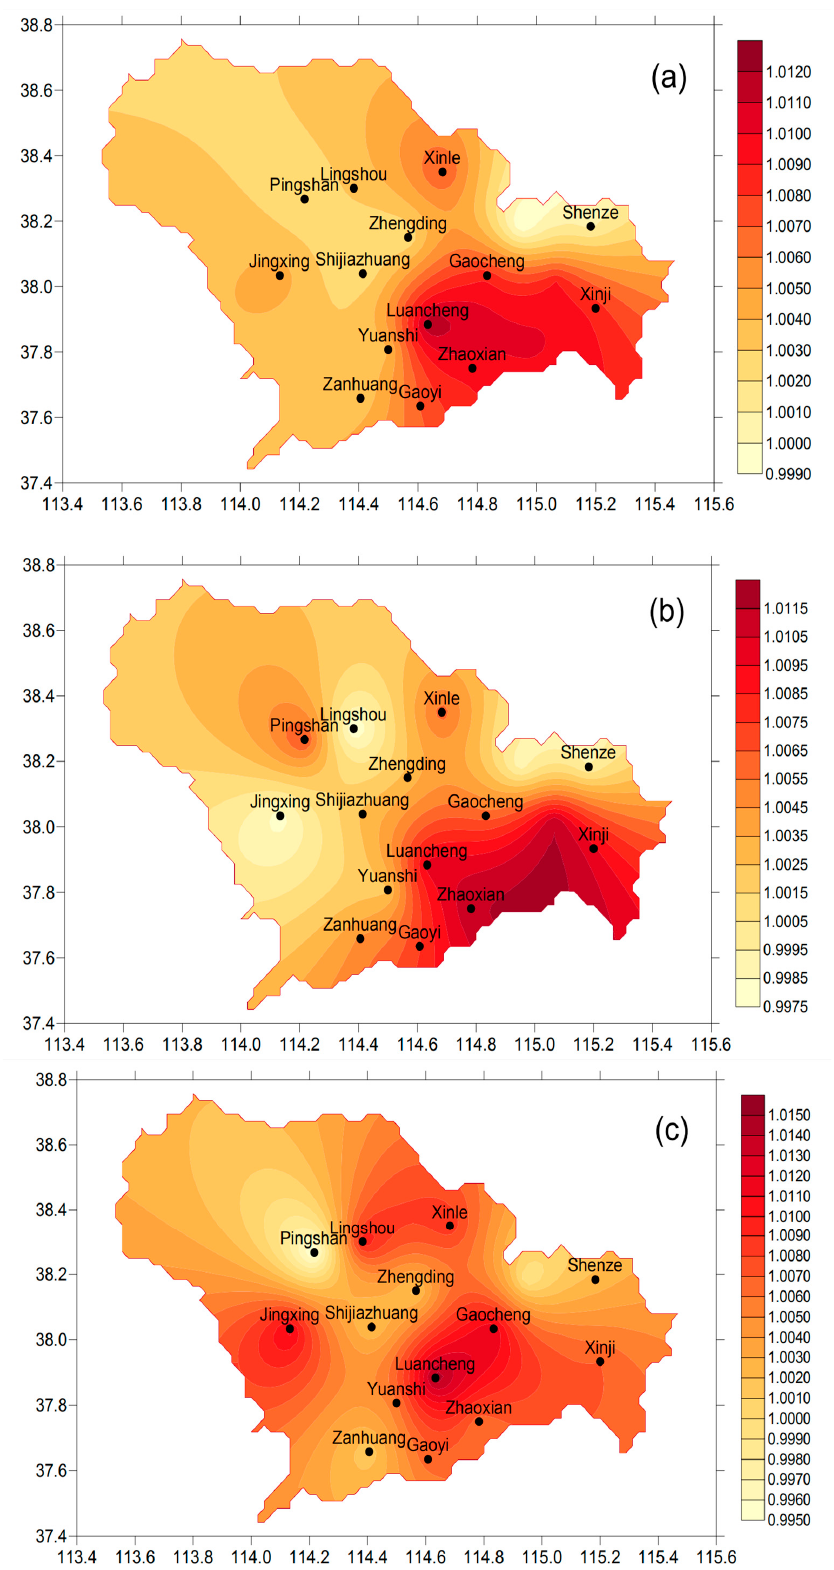
Figure 3. Relative risk (RR) of the PM 2.5 concentration on the number of deaths from circulatory diseases in Shijiazhuang City from 2014 to 2016. ( a ) Total population, ( b ) males and ( c )